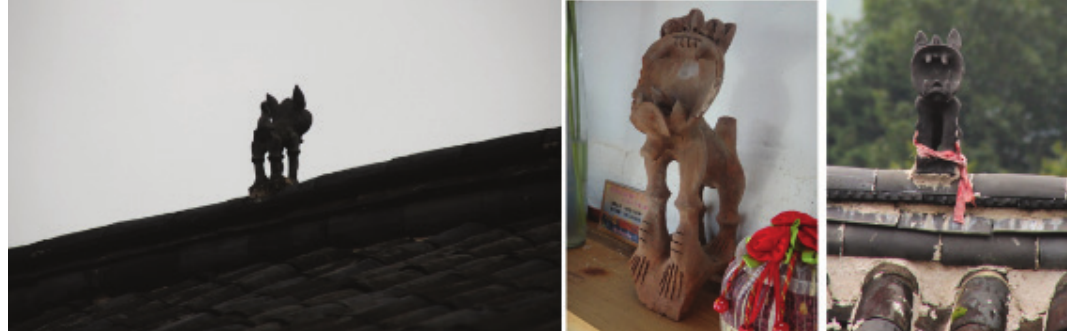
Figure 19. Tile ca ts (photos by the fi rst